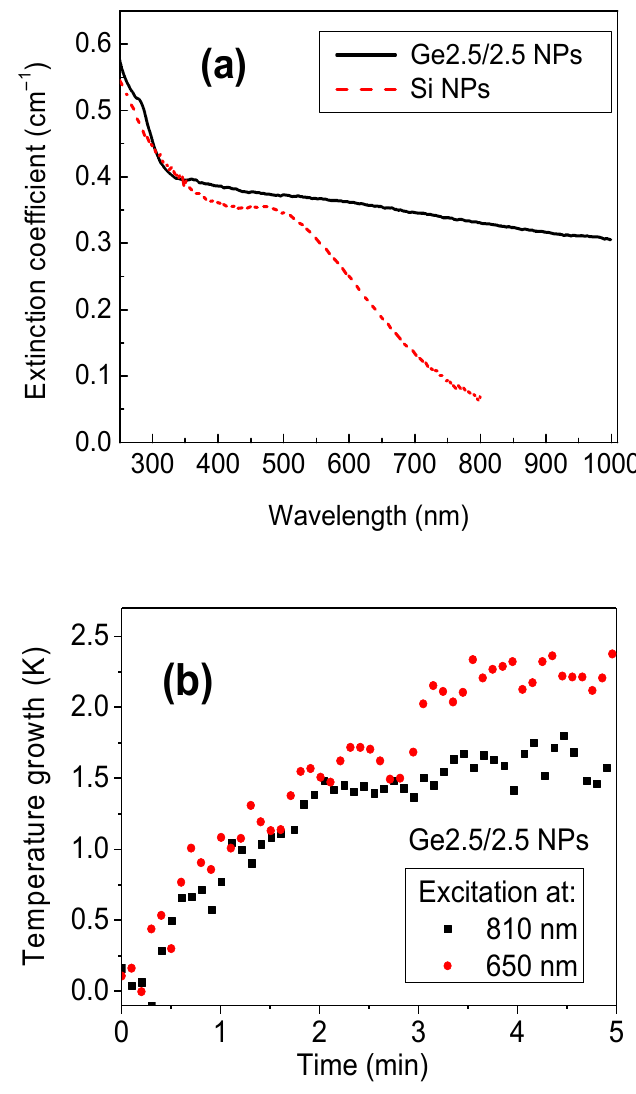
Figure 6. ( a ) Extinction spectra from a suspension of laser-synthesized Ge NPs (Ge2.5/2.5 sample) at concentration of 0.1 mg/mL (black curve) and that of laser-synthesized Si NPs at the same concentration (red dashed curve) from Ref. [46]; ( b ) temperature growth of the suspension of Ge NPs (sample Ge2.5/2.5) under photoexcitation with the wavelengths of 650 (red circles) and 810 (black squares) nm.